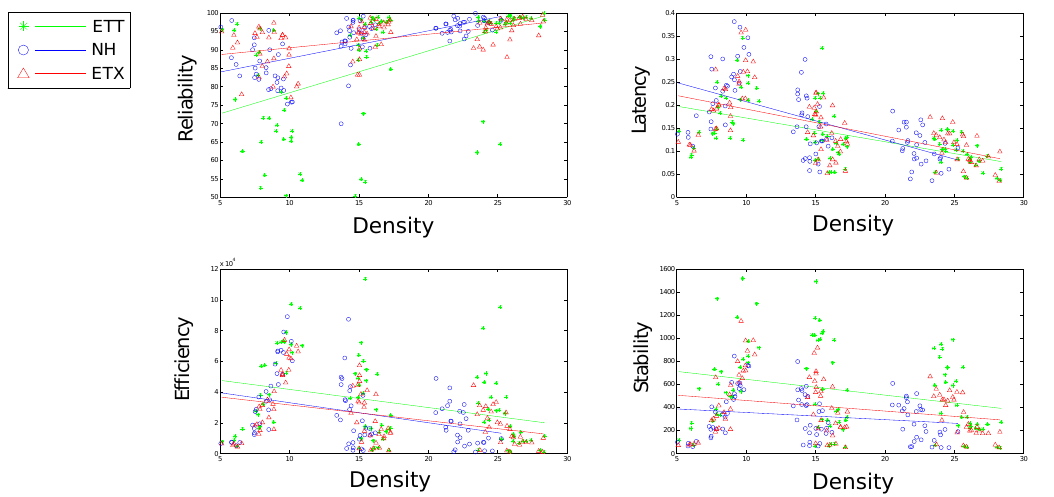
Figure 11. Network response from each solution as density